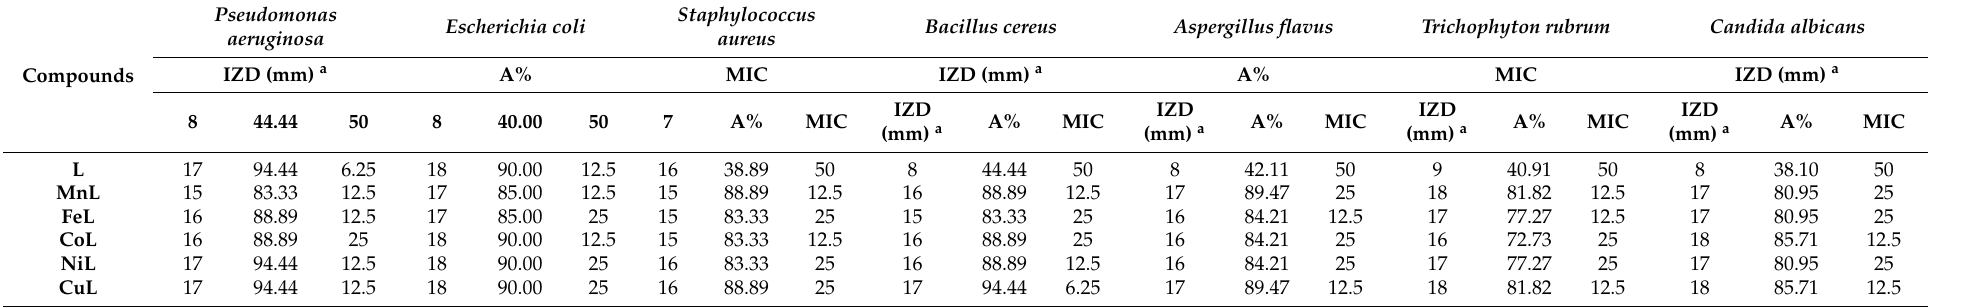
Table 4. The antimicrobial properties of the compounds in terms of zone inhibition (IZ, mm), and activity index (%).